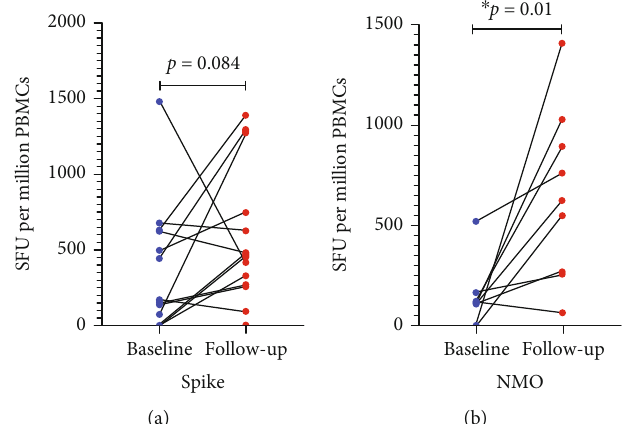
Figure 1: SARS-CoV-2-speci fi c T cell responses between baseline and follow-up. (a) T cell responses against spike S1 subunit at baseline and follow-up. (b) T cell responses against NMO at baseline and follow-up.